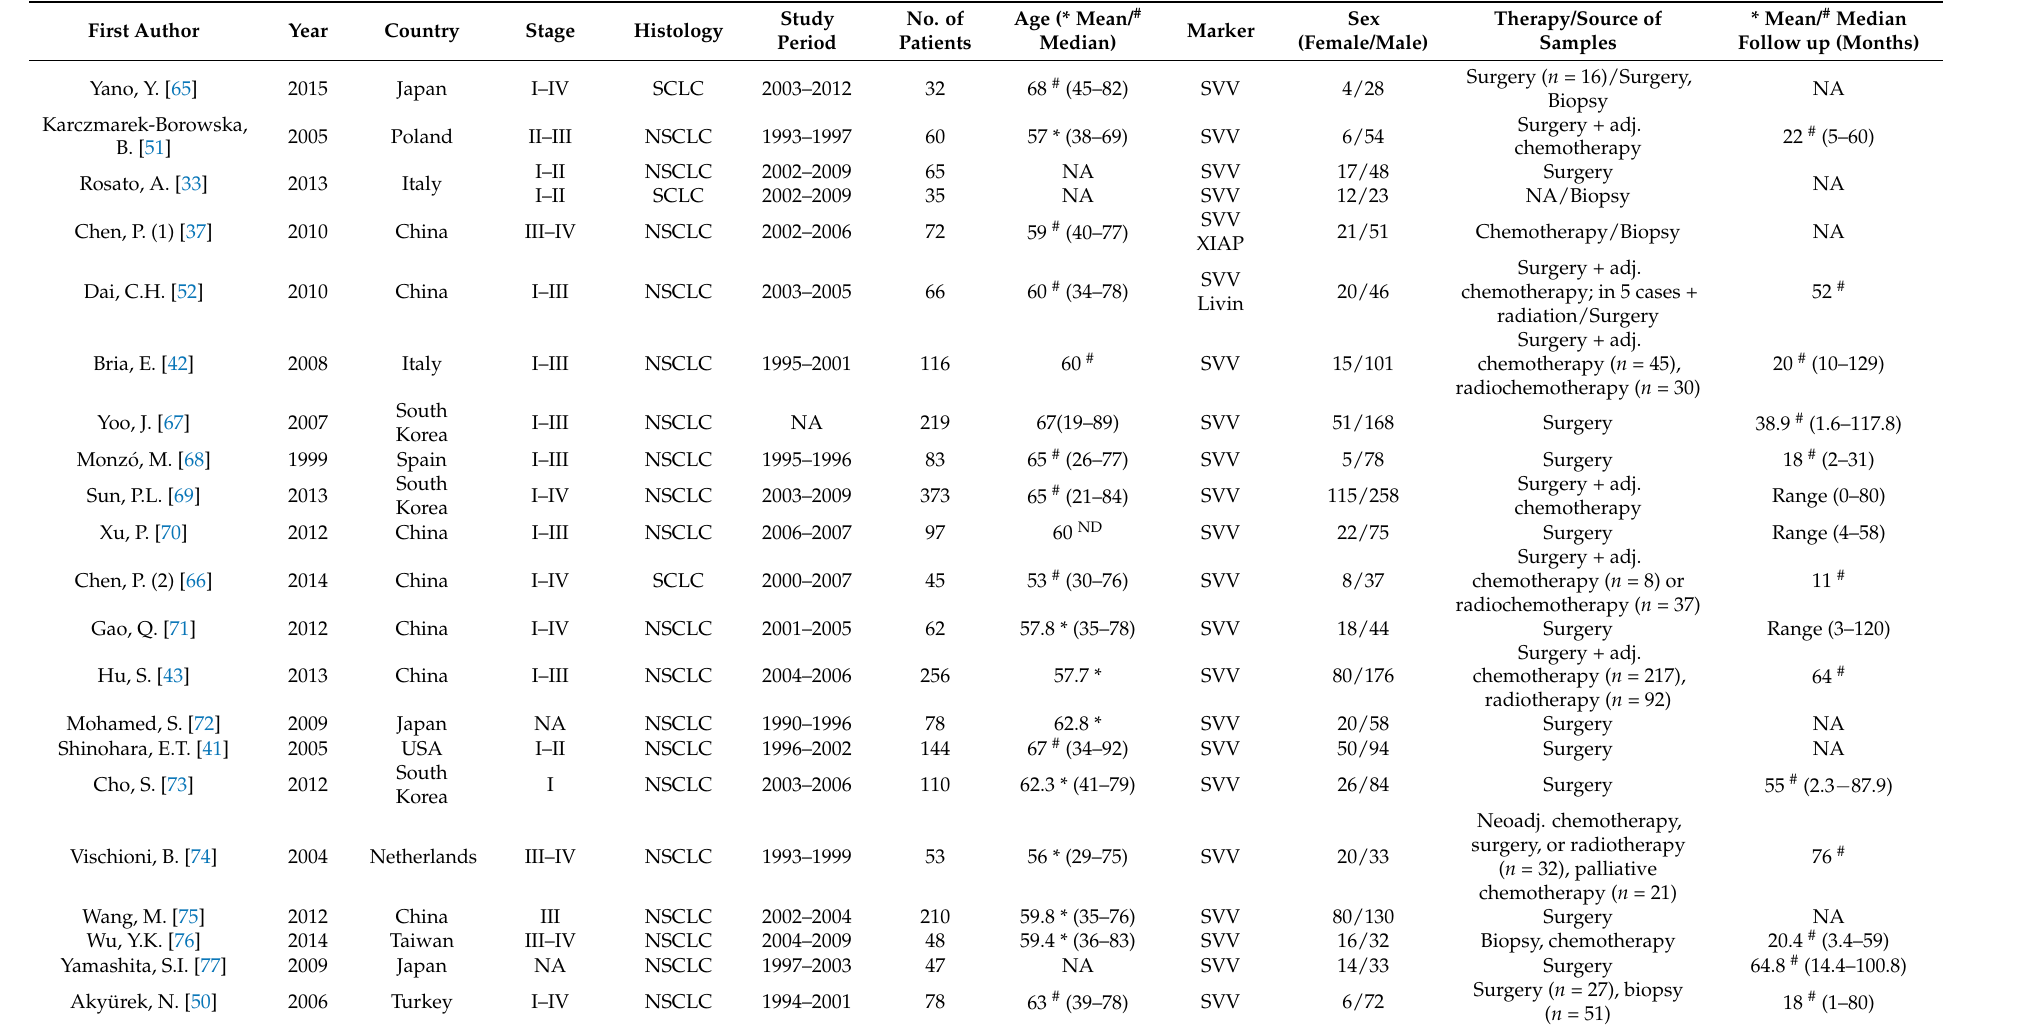
Table 1. Clinical characteristic of included